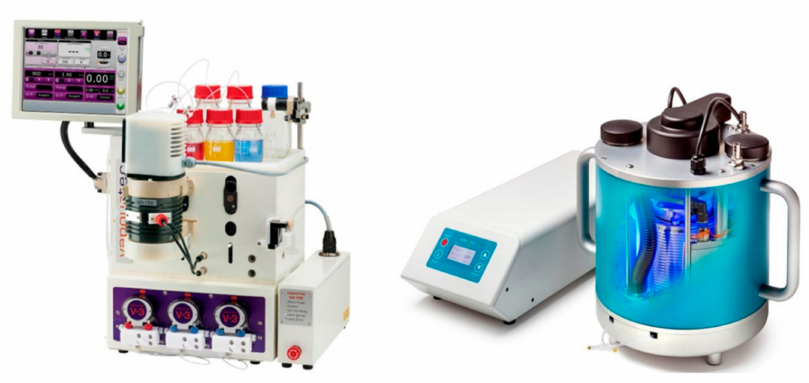
Figure 6. Images of the Vapourtec high-power LED reactor and Uniqsis’s PhotoSyn